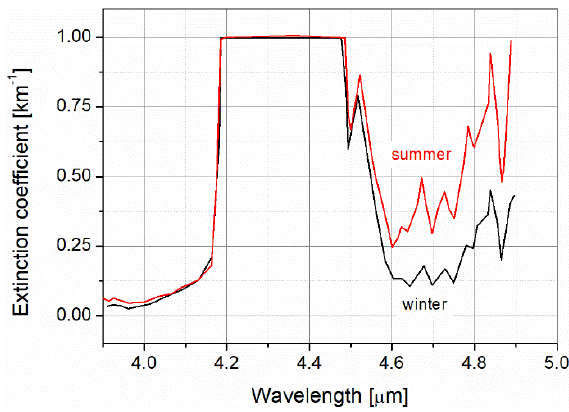
Figure 6. Averaged extinction coefficient for summer and winter. According to these characteristics, the values of extinction coefficient used in the link budgets are listed in Table 6. Table 6. Extinction coefficients for two lasers simulated for two weather seasons.